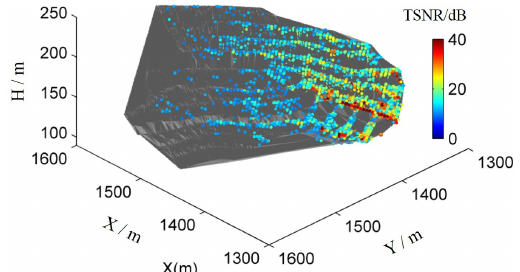
Figure 11. Mapping of TSNR map to digital elevation model. We selected the radar image of the high slope area, and the TSNR threshold was set to 10dB to eliminate the weak part of the signal in the image. As the angle of the high slope in the experiment deviates from radar centre line, the reflected signal in right part of side slope is relatively ideal. GB-SAR image pixels of edge beside the third horse road is clear, which is directly connected to the outer wall of the 4 water